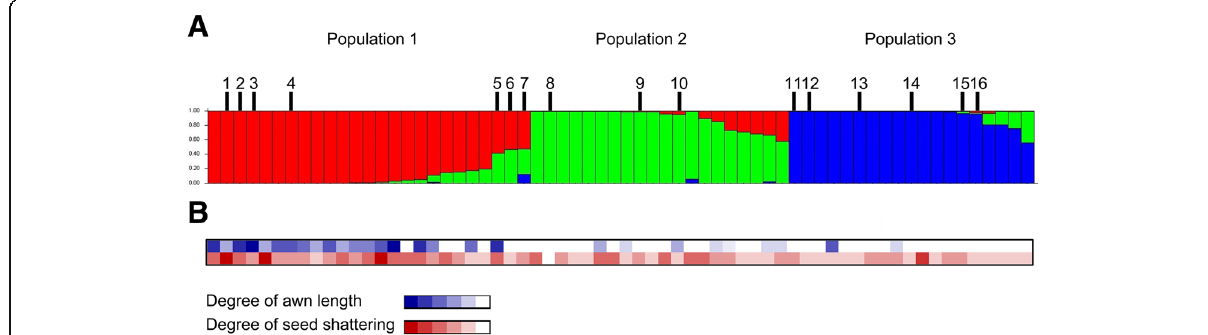
Fig. 2 Classification of 60 Formosan upland rice accessions and 4 control varieties using STRUCTURE v2.3.1 with K set at 3. Panel a . Population 1 (red) primitive japonica ; population 2 (green): relatively modern japonica ; population3 (blue): indica . Numbers above the main graph identify accessions discussed in the text: 1, Nakairitsu; 2, Kabotsumame; 3, Matara; 4, Chuan No4; 5, Bohai; 6, Purahaitairin; 7, Montana; 8, Nipponbare; 9, Nakabo; 10, Muteka; 11, Ragarasu; 12, Tangengenrankatsu; 13, Tapopuri; 14, IR64; 15, Nobohai; 16, Parahainakoru. Panel b . Degree of awn length (blue; white indicates no awn) and seed shattering (red; white indicates no shattering) of each accession. The list of accessions is shown in Additional file 1: Table S4, and the seeds are available at National Germplasm Center, Taiwan Agriculture Research Institute, Taiwan and